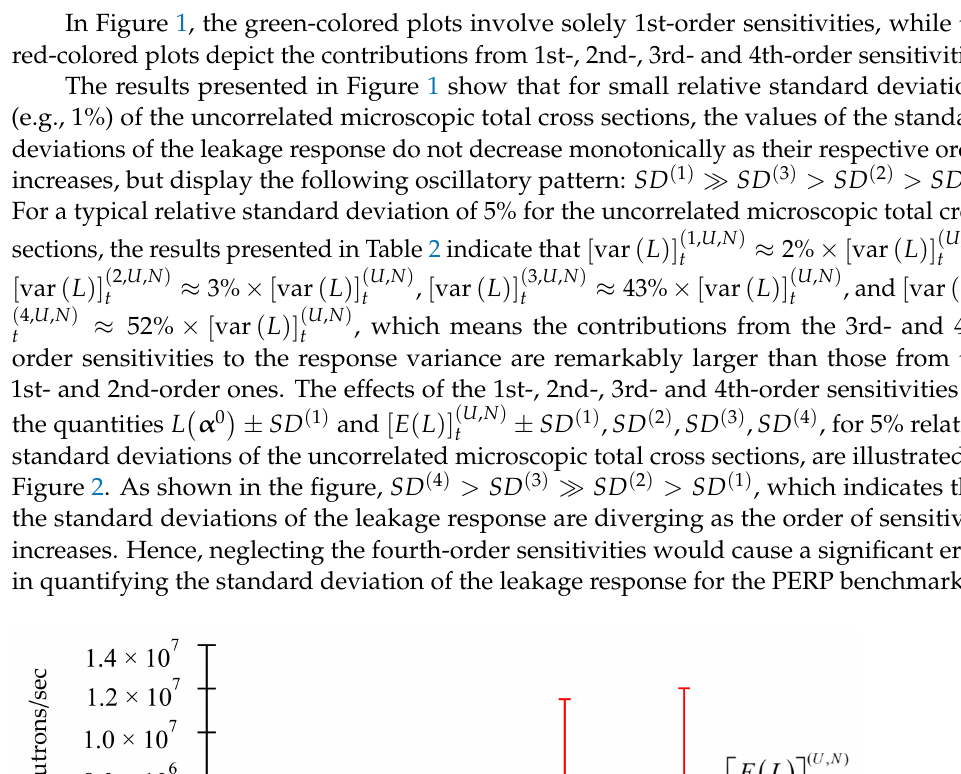
Figure 2. Comparison of L due to 5% standard deviations of the uncorrelated microscopic total cross